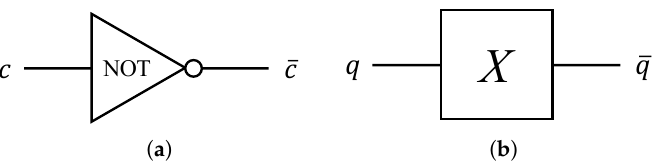
Figure 1. NOT gates in binary and quantum circuits. ( a ) NOT gate in a classical binary circuit, which has input c and output c (the complement state of c ). ( b ) NOT gate in a quantum circuit (X gate), which has input q and output q